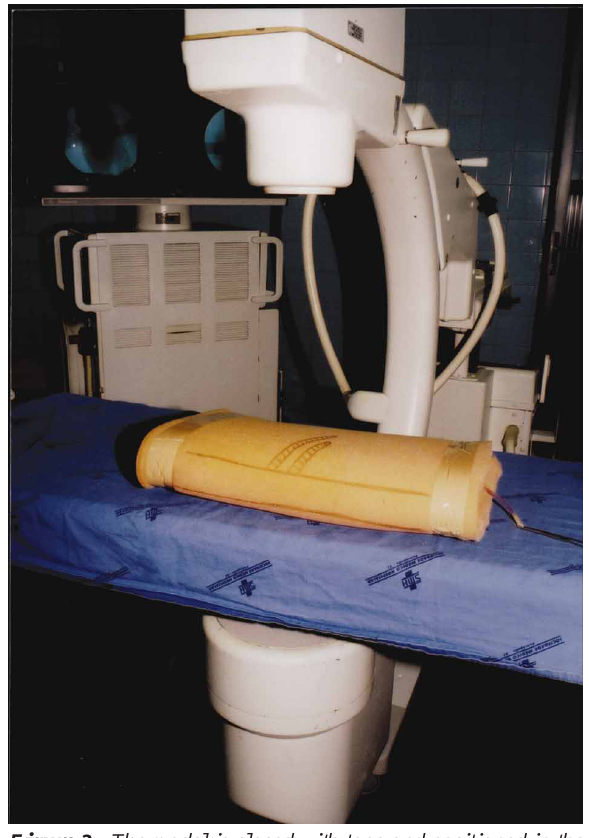
Figure 3 - The model is closed with tape and positioned in the radioscopy table. It is noted the drawing of 11th and 12th ribs, and posterior axillary line. The ureteral catheter is outside the